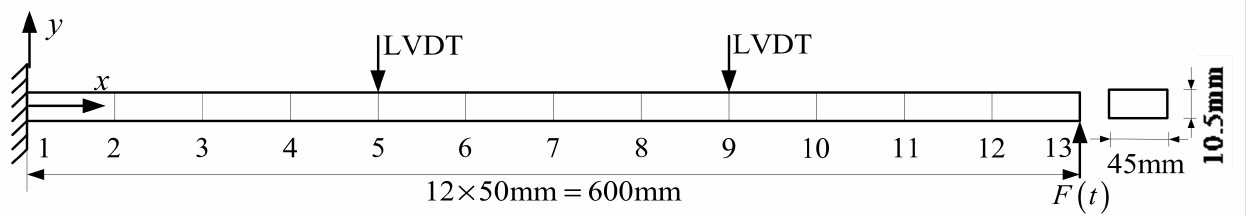
Figure 13. Schematic diagram of our cantilever beam tester.